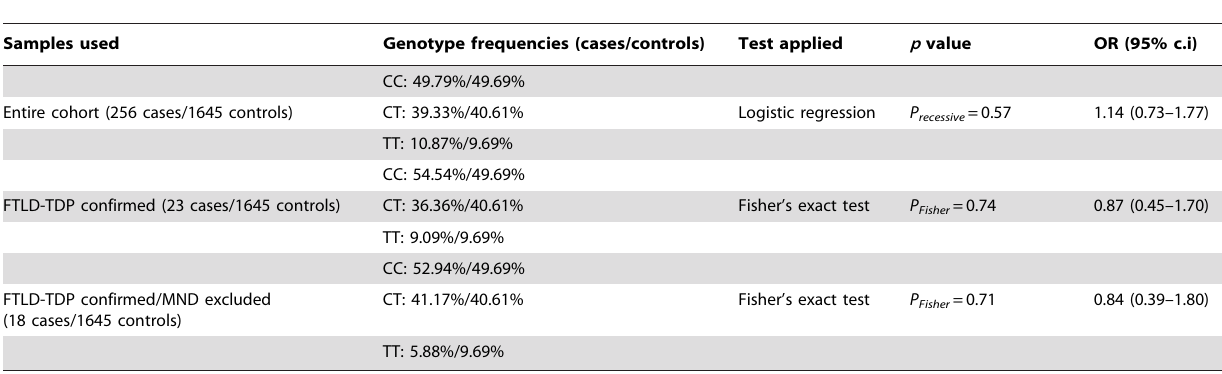
Table 1. Genotype frequencies and association results for the tests performed in the Dutch series.